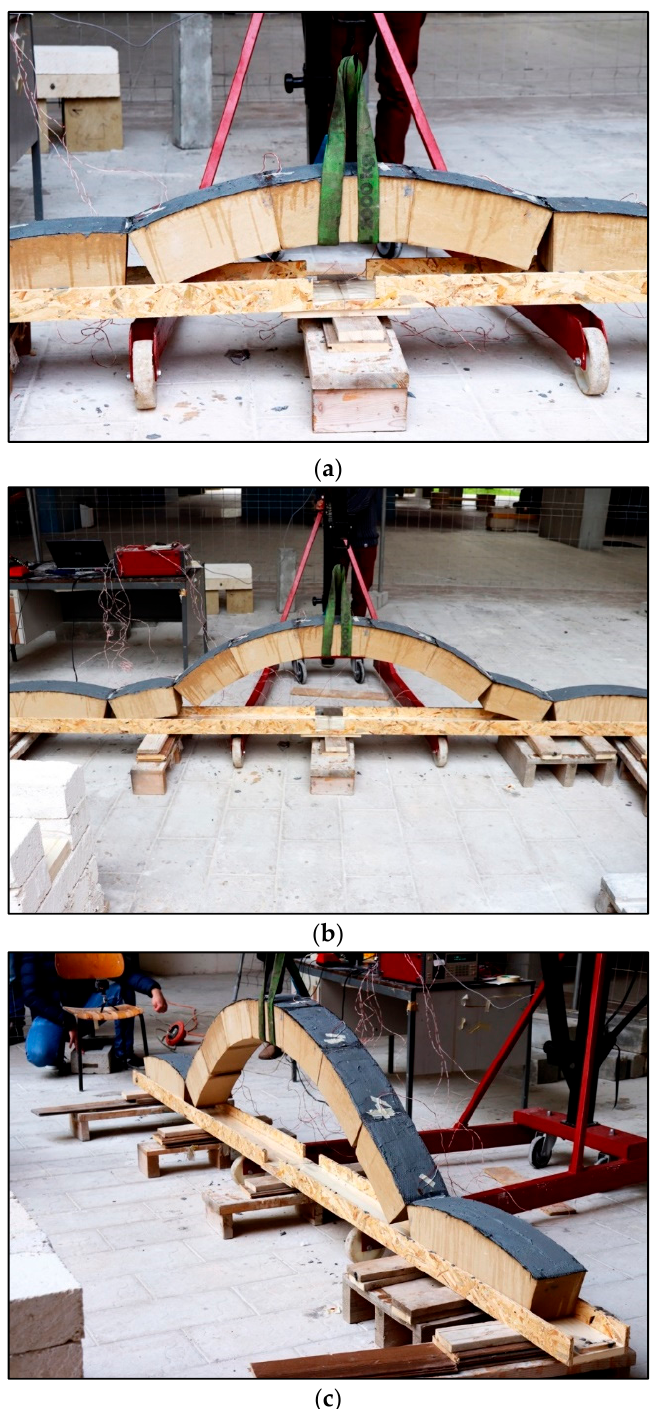
Figure 10. Detail of the Linear Variable Differential Transformer (LVDT) installation.